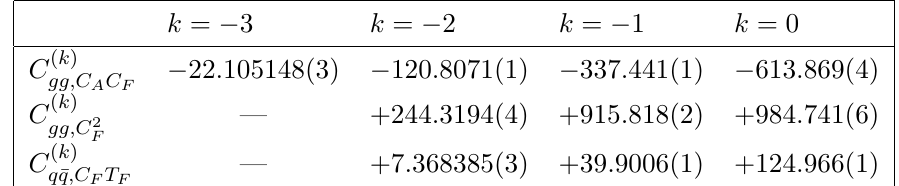
Table 6. Coe(cid:14)cients of the (cid:15) expansion of the integrated double-soft function for gg channel ((cid:12)rst two rows), and the q (cid:22) q channel (the last row). We use m b = 4 : 78 GeV and M H = 125 : 09 GeV. The integrated double-soft function can be written as a Laurent series,